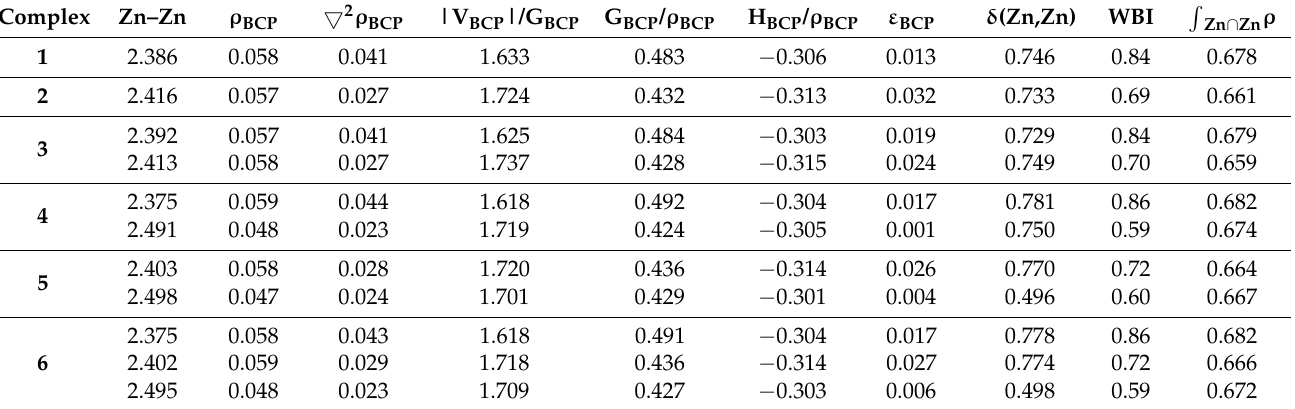
Table 2. Selected local and integrated topological properties of the electron density at the Zn–Zn BCP for complexes 1 – 6 a